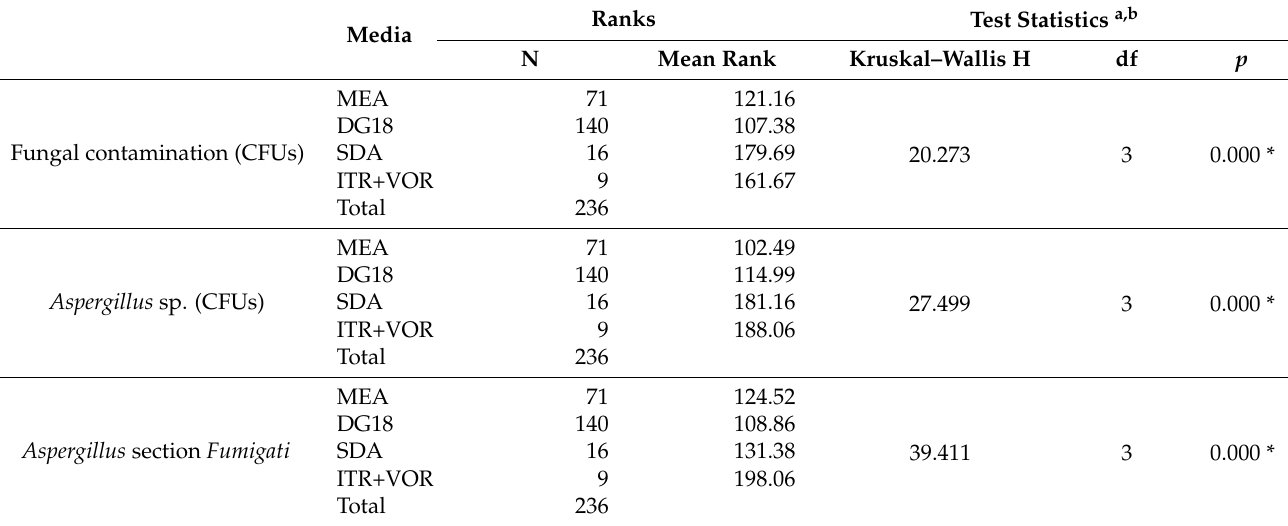
Table 6. Comparison of Fungal contamination, Aspergillus sp. and Aspergillus section Fumigati between media. Kruskal– Wallis